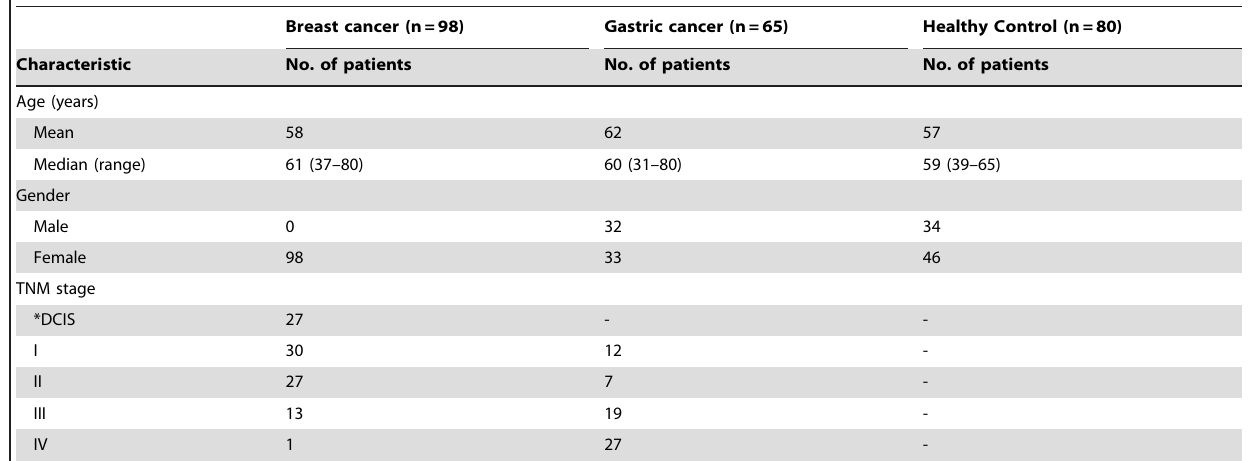
Table 1. Patient characteristics.